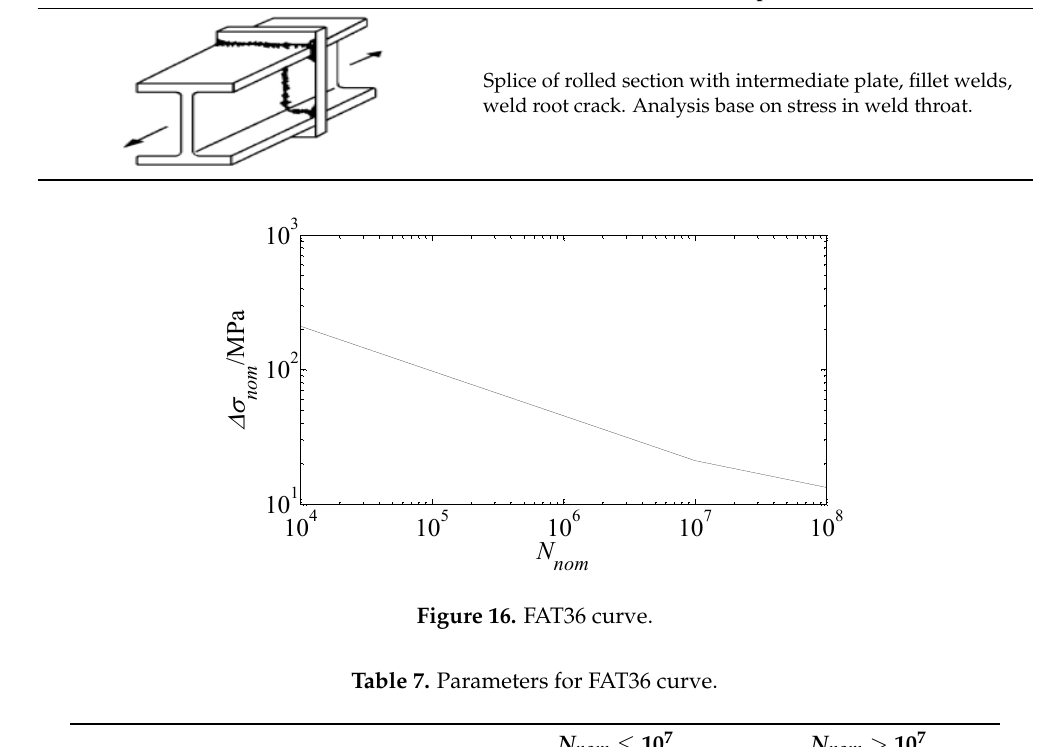
Table 7. Parameters for FAT36 curve.